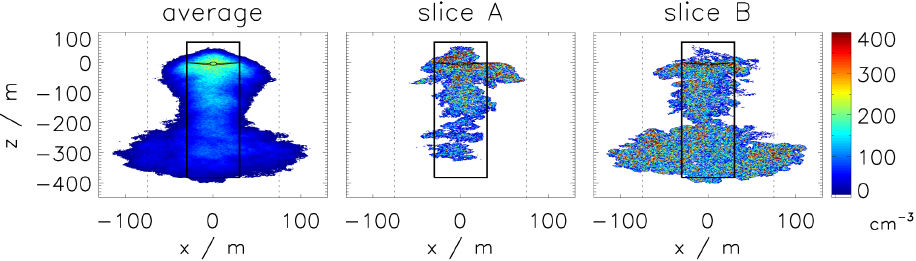
Figure 8. Ice crystal number concentrations in a plane normal to the flight direction after 4min. The displayed simulation is no. 9 from Table A2. In the left panel the number concentrations are summed up along flight direction and divided by the length of the flight segment. In the middle and right panel, two slices along flight direction are extracted. The dotted vertical lines indicate the W = 150m-approximation (i.e. x = ± 75m). The black box indicates effective volume of the contrail. The box height equals the H value given in Table A2. The width W rect is given by A/H , where A is the longitudinally averaged cross